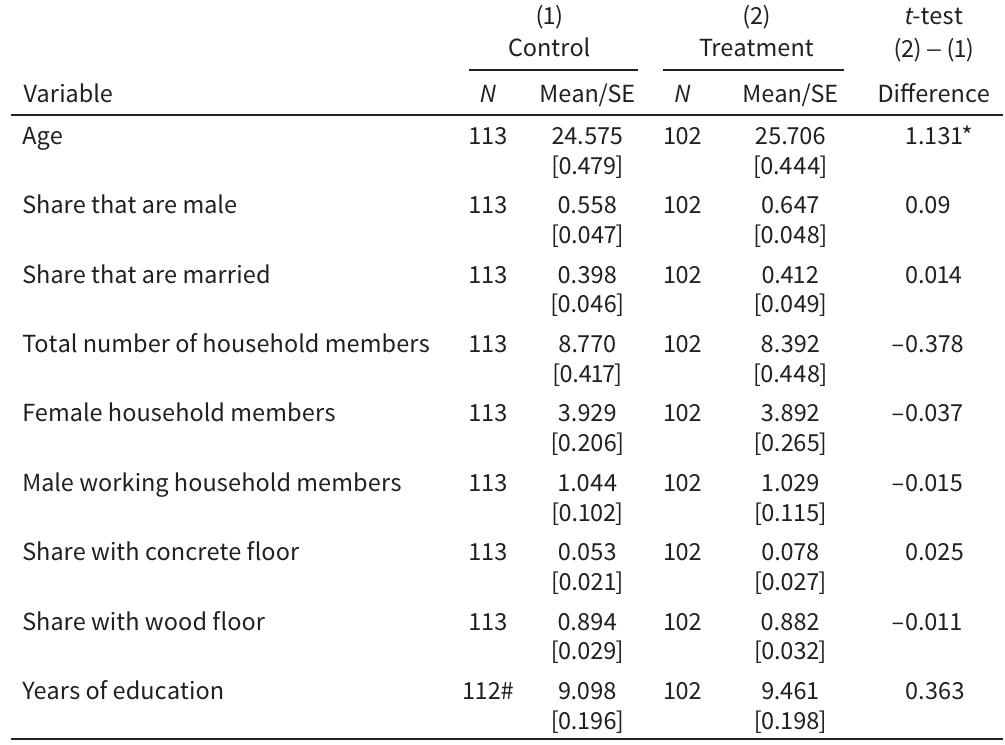
Table 2 Statistical balance across background characteristics (1) (2) t -test Control Treatment (2) -